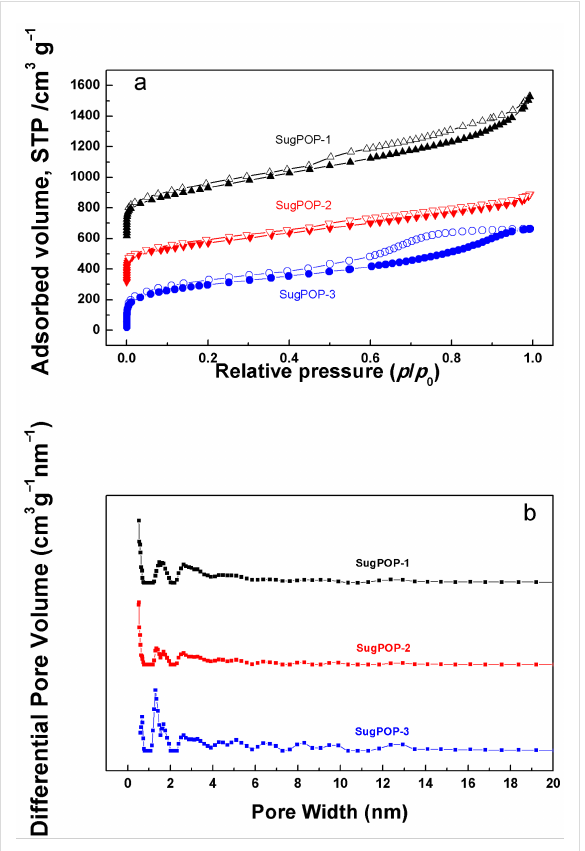
Figure 2: (a) Nitrogen adsorption–desorption isotherms of SugPOP- 1–3 measured at 77 K. For clarity, the isotherms of SugPOP-1 and SugPOP-2 were shifted vertically by 600 and 300 cm 3 g − 1 , respective- ly. (b) PSD profiles of SugPOP-1–3 calculated by NLDFT analysis at 77